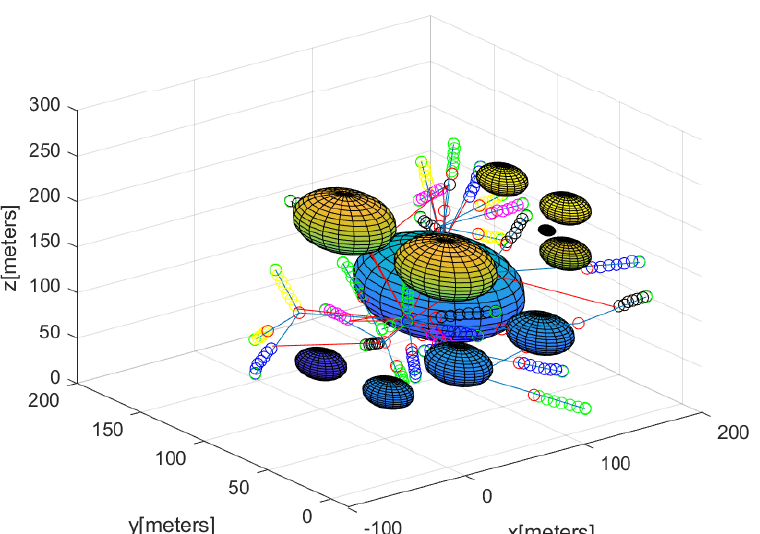
Figure 9. Every UUV’s maneuver until t = 20 s have passed (one MC simulation). Every UUV’s maneuver is illustrated as circles with a distinct color. At t = 0 s, we build a tree T (blue line segments) containing all UUVs. At t = 20 s, 25 broken UUVs are illustrated with red circles. At t = 20 s, we re-build a connected tree T without broken UUVs. The re-built tree T is marked with red line segments. Obstacles are plotted with